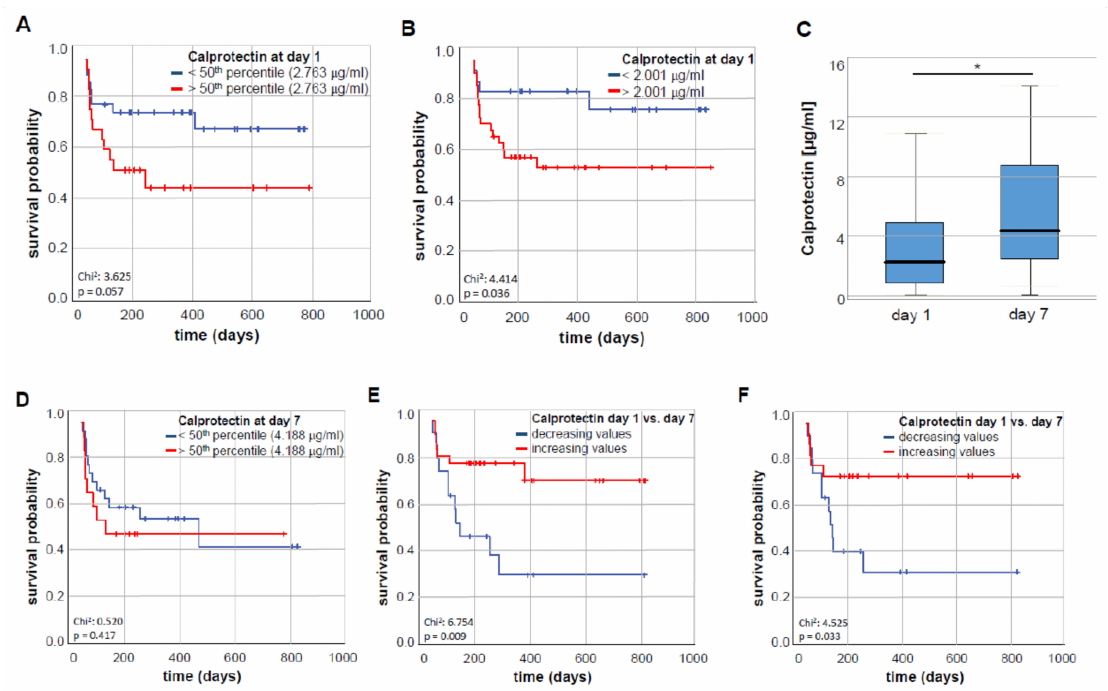
Figure 3. Calprotectin serum concentrations during the course of critical illness. ( A ) Using the median calprotectin serum level (2.763 µ g / mL) as cut-o ff value, Kaplan–Meier curve analysis reveals a